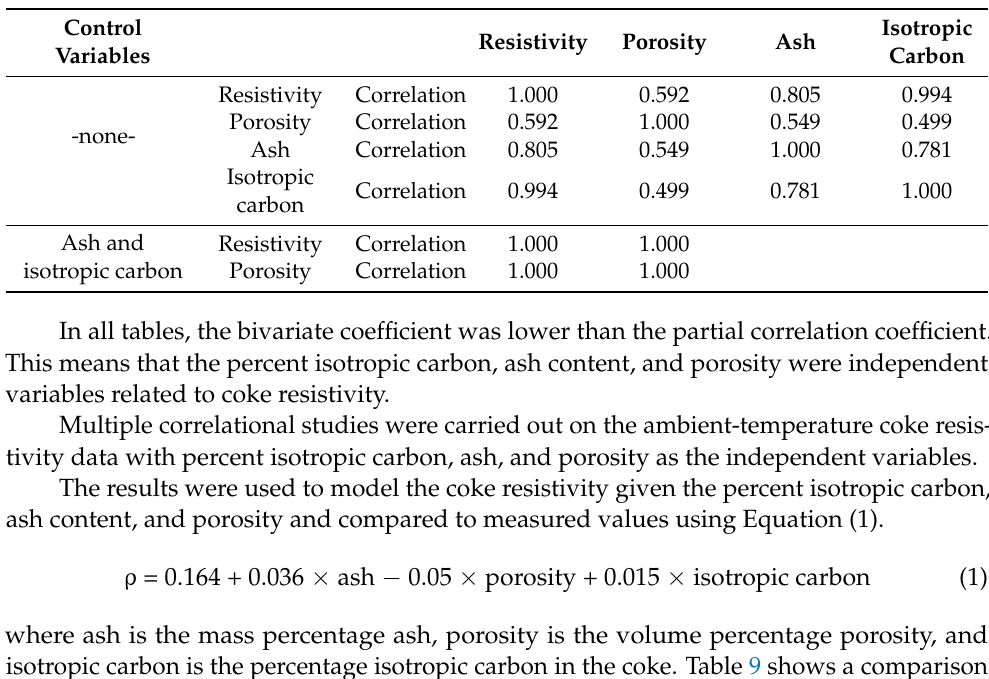
Table 8. Correlation matrix of coke resistivity and coke porosity while controlling for both precent isotropic carbon content and ash content.